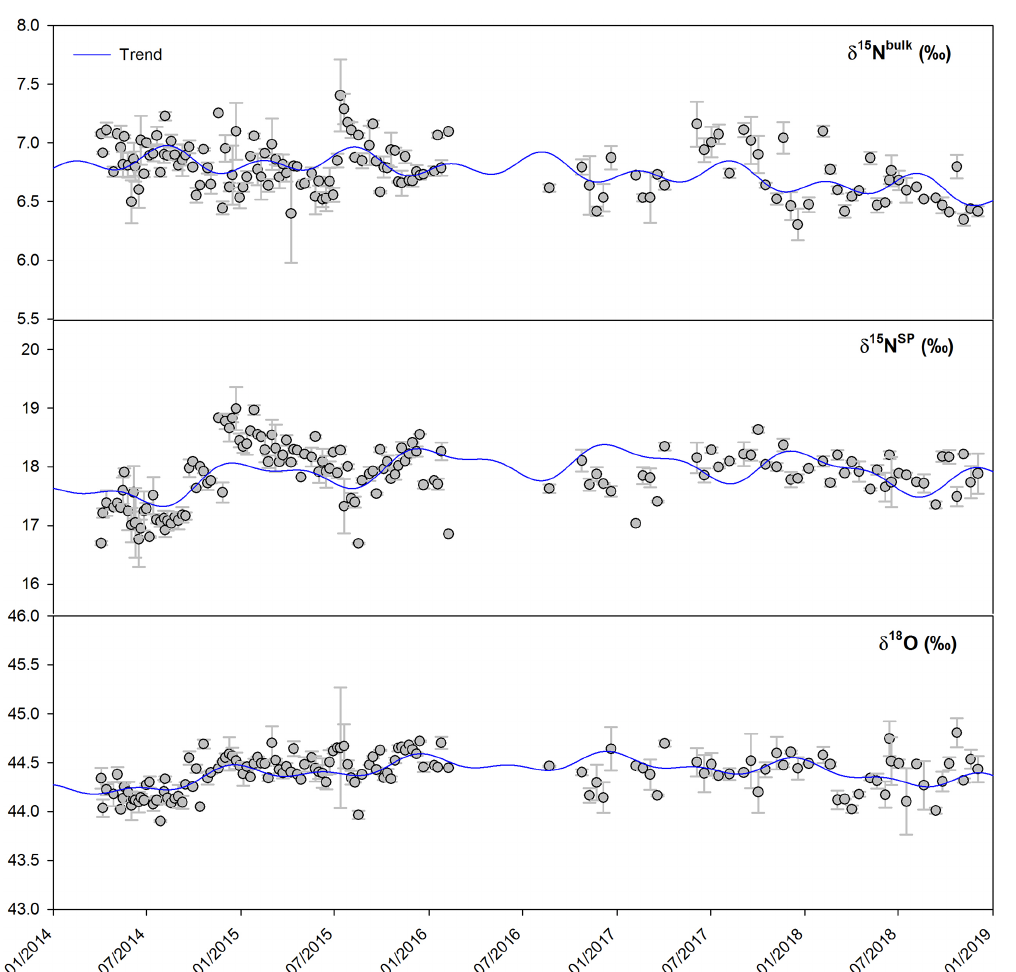
Figure 2. Time series of isotopic composition of atmospheric N 2 O observed at Jungfraujoch from April 2014 to December 2018. Error bars indicate 1 standard deviation of repeated measurements. Blue lines indicate the simulated trends by the NLS